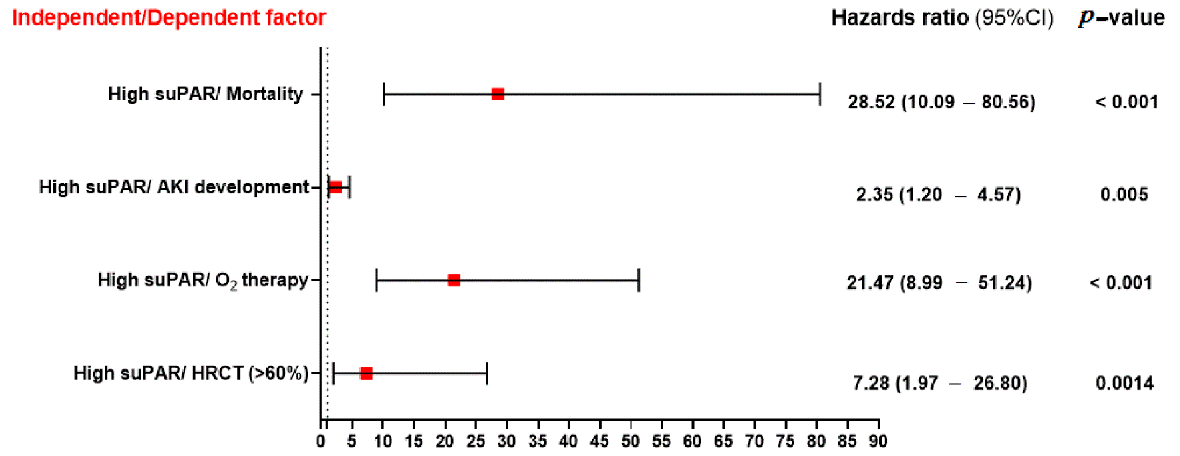
Figure 4. The association between serum suPAR level and other dependent variables such as mortality, AKI development, oxygen therapy, and CT condensation. Significance was set at p < 0.05.